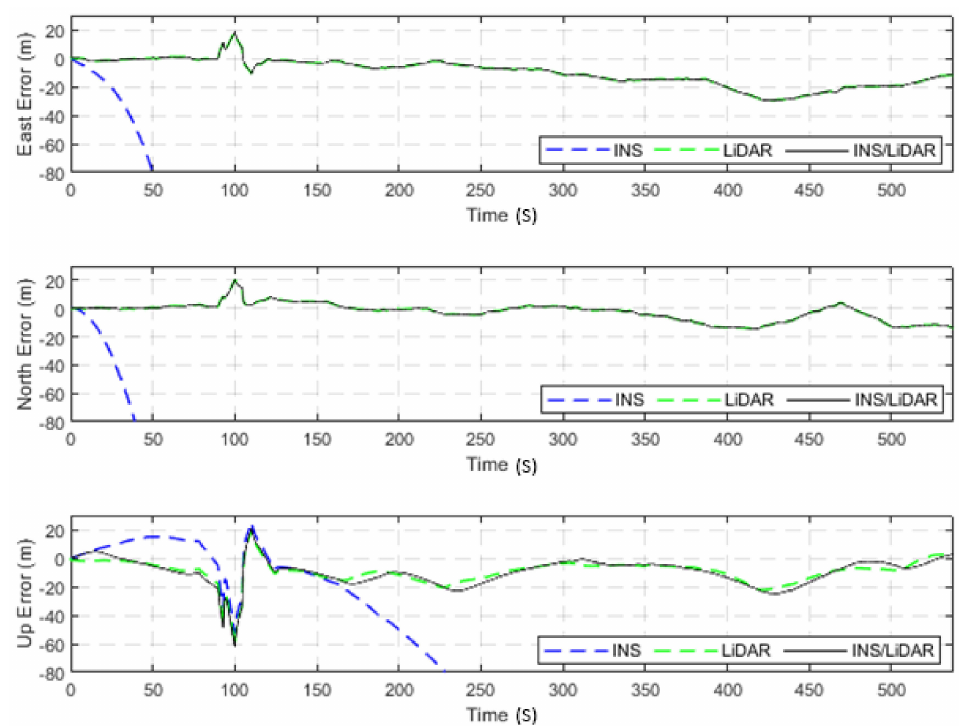
Figure 6. D-28—complete GNSS signal outage: position errors